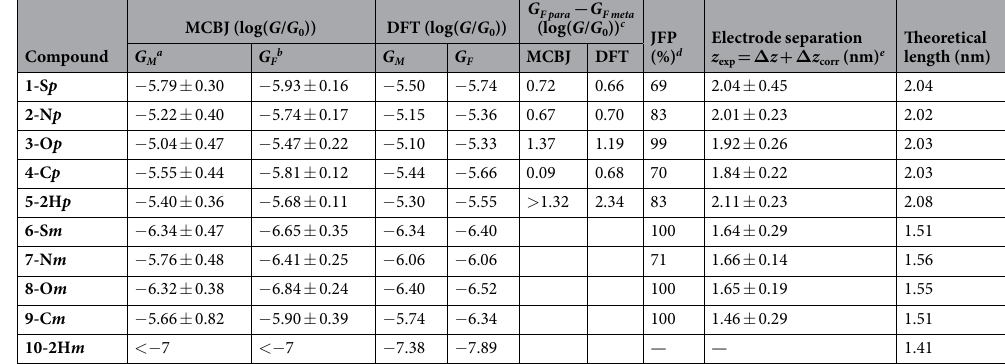
− 7.89 — — 1.41 Table 1. Most Probable Conductance Values as Obtained from MCBJ Experiments and Computations. a Conductance fitted by Gaussian function in the 1D histogram. b Molecular conductance through fully stretched junction obtained by linear fitting of the master curve. c Fully-stretched conductance difference between para - and meta -linked molecule for each bridging unit. d Junction formation probability judged by area ratio of the peak in the plateau length distribution. e Most-probable electrode separation at the end of conductance plateau. Error bars are based on the Gaussian fitting of conductance all-data-point 1D histogram and plateau displacement